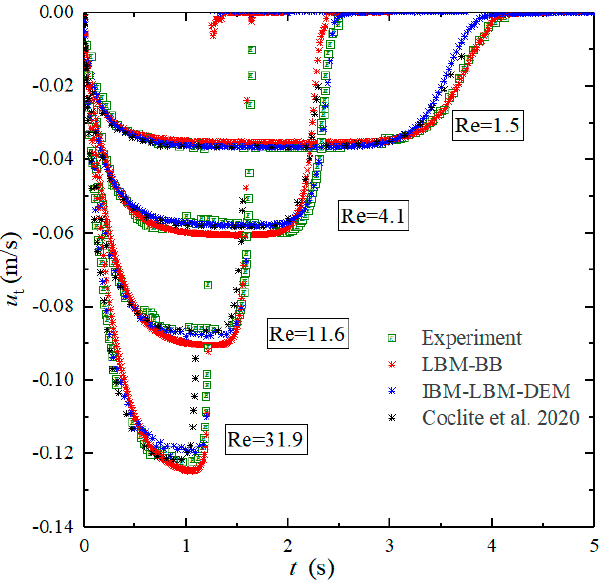
Figure 3. Evolution in the settling velocity from Coclite et al. [42], Experiment [43] LBM-BB and IBM-LBM-DEM.